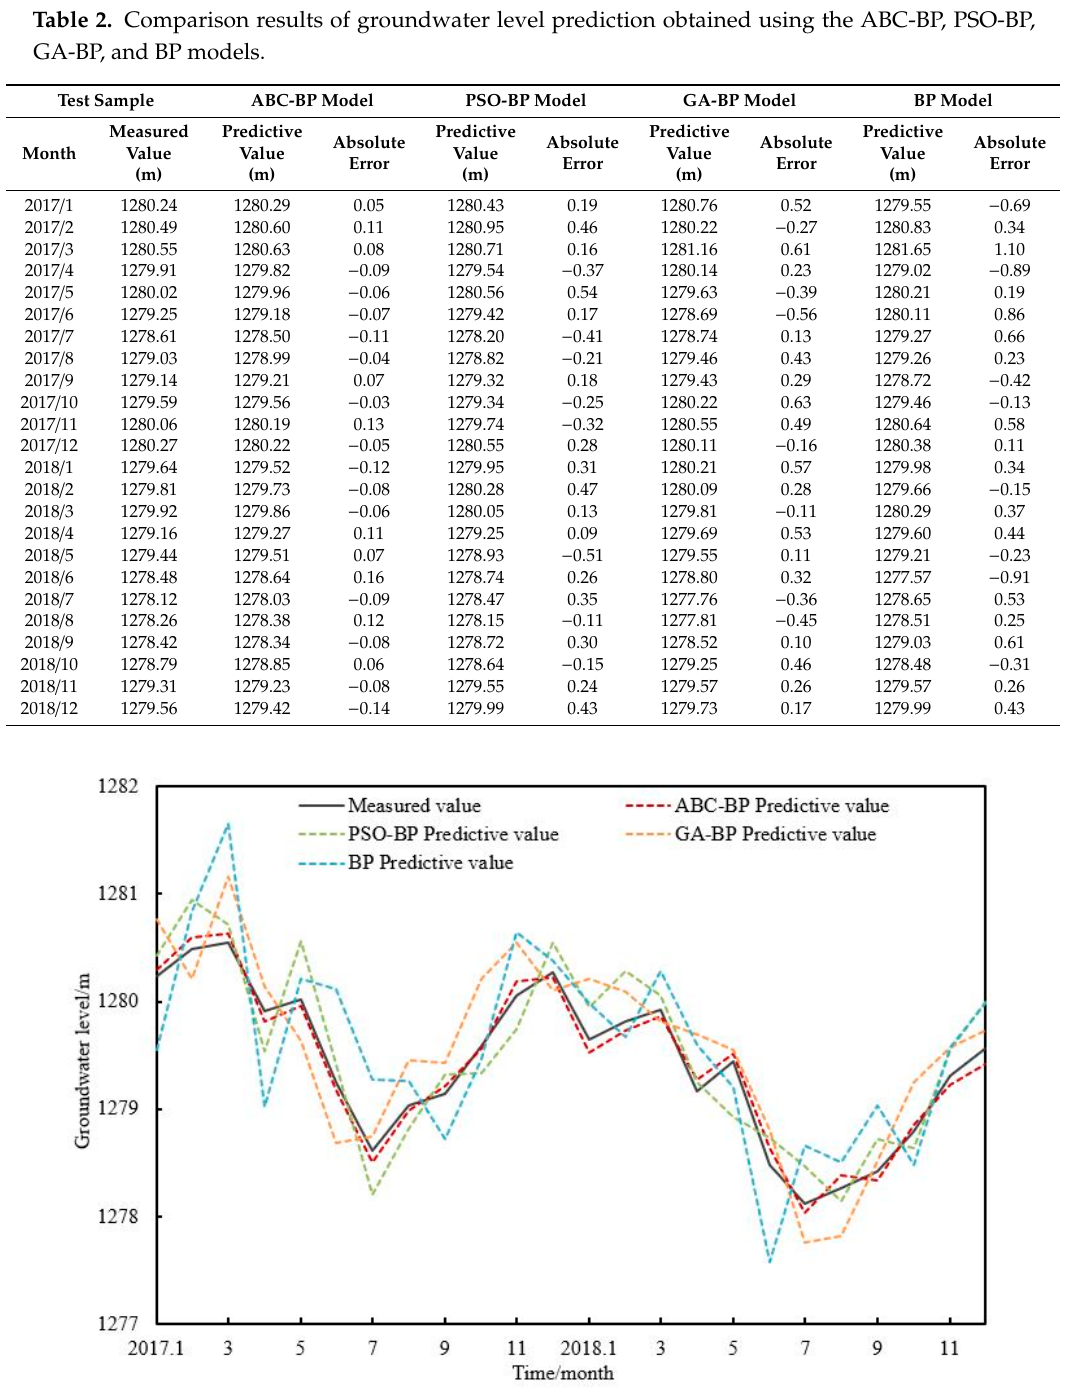
Figure 7. Fitting curve of the measured and predicted values obtained using the ABC-BP, PSO-BP, GA-BP, and BP